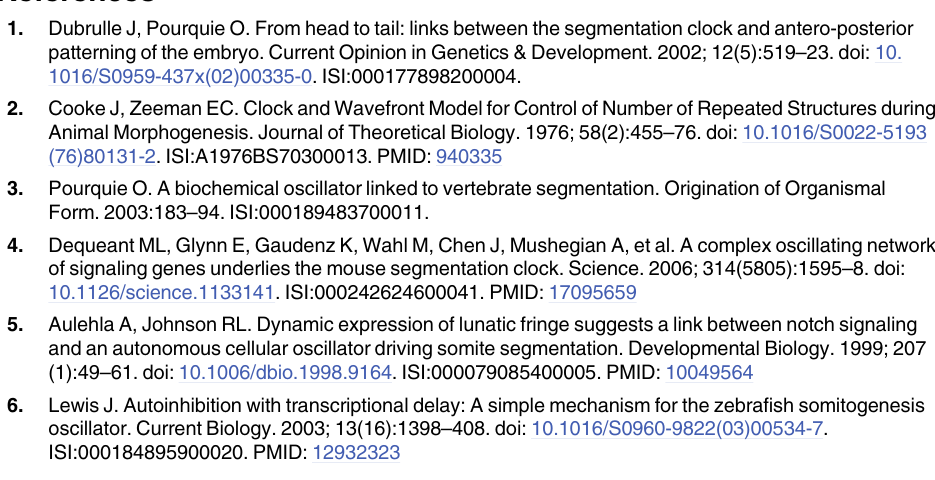
S4 Table. The list of genes with two peaks of expression during zebrafish somitogenesis. The timing of genes found with two peaks of expression during zebrafish somitogenesis, ranked according to their LS p-value and the regularity of the profile. Times in minutes assume a 30mn periodicity for every transcript and errors are computed by adding to the original tran- script source of noise typically found in microarray experiments. S5 Table. The list of known cell cycle genes enriched with the GC-rich motif A1 in their promoters. From the set of 1134 genes identified to periodically expressed during cell cycle, only 112 were found to have the GC-rich motif A1 in their promoters. This low overlap (~10%) demonstrates that the GC-rich motif is not significant in the cell cycle, in agreement with previous results in that the cell cycle and the periodic activation of gene expression during somitogenesis are two separate and independent processes. S6 Table. Influence of the length of the promoter on the motif analysis of cyclic genes. We compare the statistics of the motif analysis for promoter lengths of 1kb, 2kb, 5kb and 10 kb. The 2kb analysis appears to be the best compromise between false positives (high for longer sequences) and false negative (high for too short sequences) and provide better gene